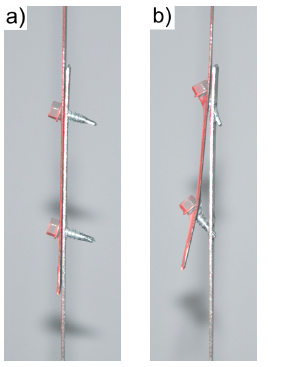
Figure 6: Failure mode of specimen from S2 group; a) captured at the reference displacement value of 3 mm; b) beyond the reference displacement value of 3 mm.